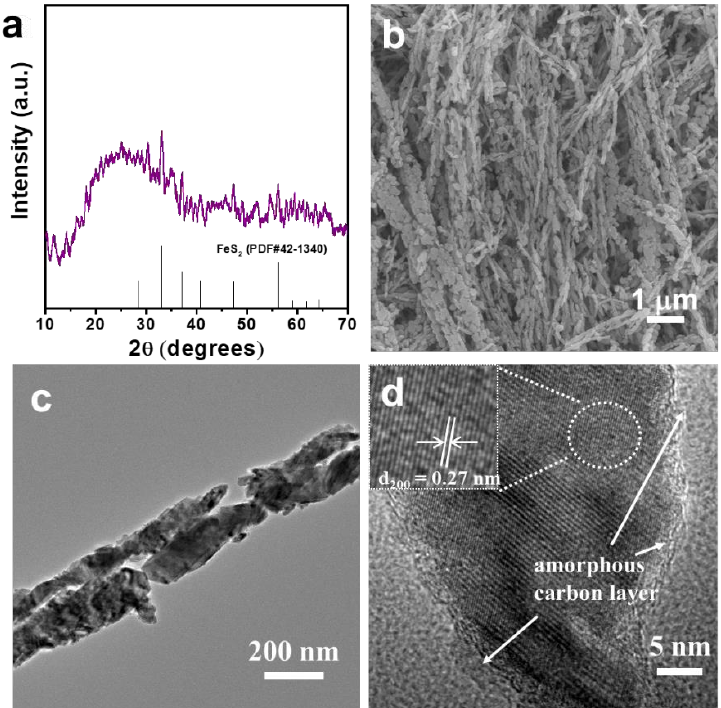
Figure 4. ( a ) X-ray diffraction (XRD) pattern, ( b ) SEM image, ( c ) TEM image, and ( d ) high-resolution TEM (HRTEM) image of as-prepared FeS 2 /C nanowires.